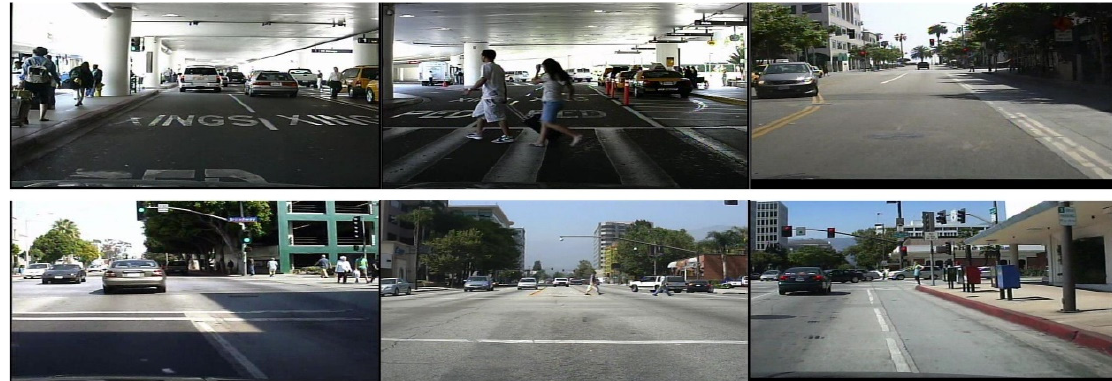
Figure 5. Example of Caltech Pedestrian dataset.